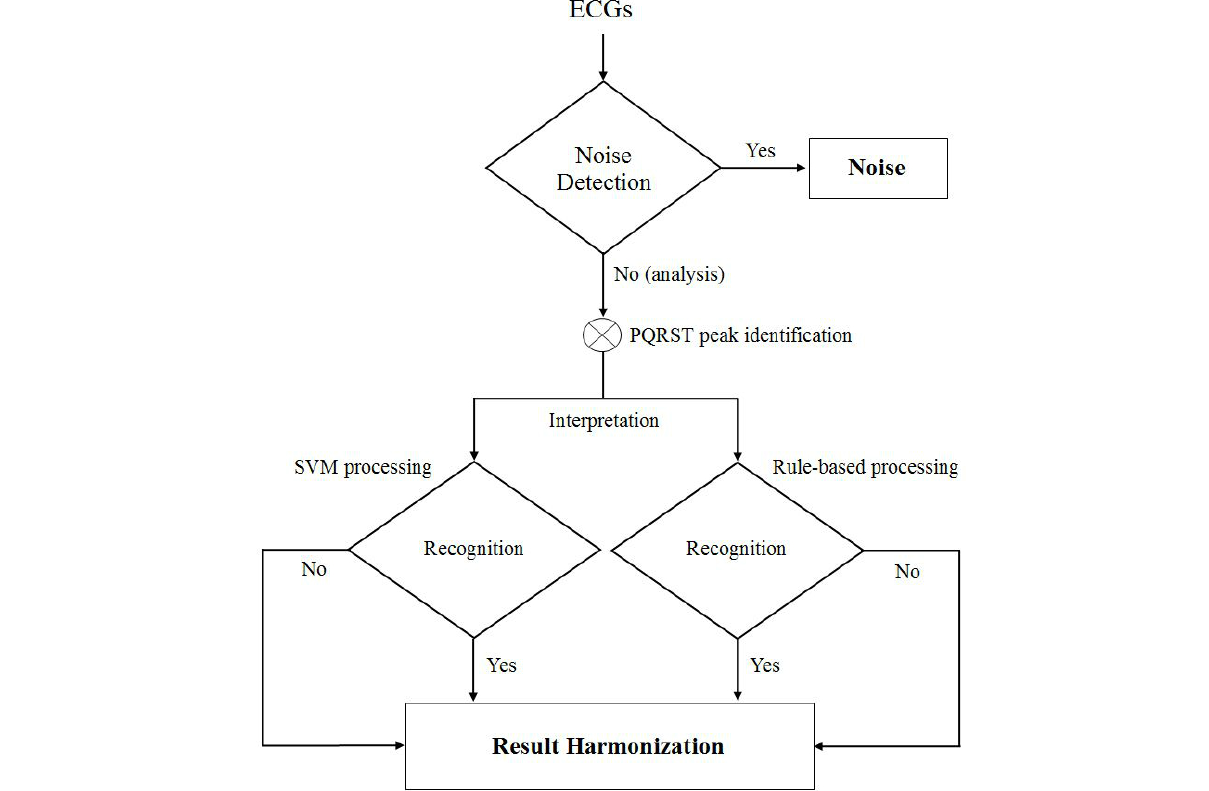
Figure 2. Flowchart of the automatic ECG recognition algorithm. Several preprocessing steps (ie, denoising, baseline removal, and feature extraction) and the classifiers of SVM and rule-based processing are applied to analyze the ECG